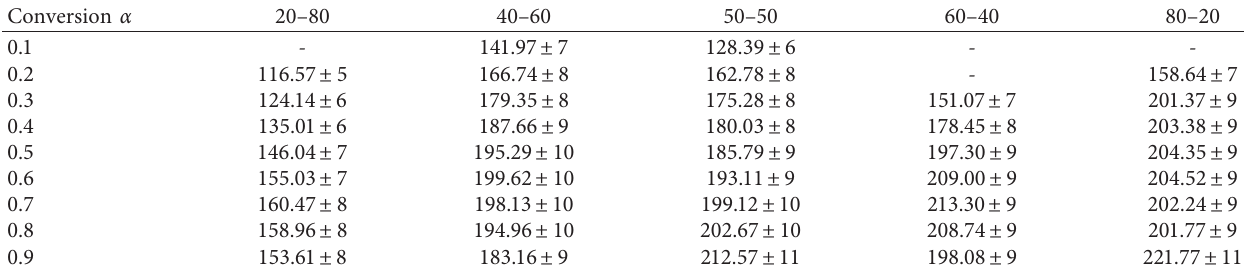
Table 5: Activation energies (KJ) by the KAS method for the PNVP- co -PSMA copolymers.